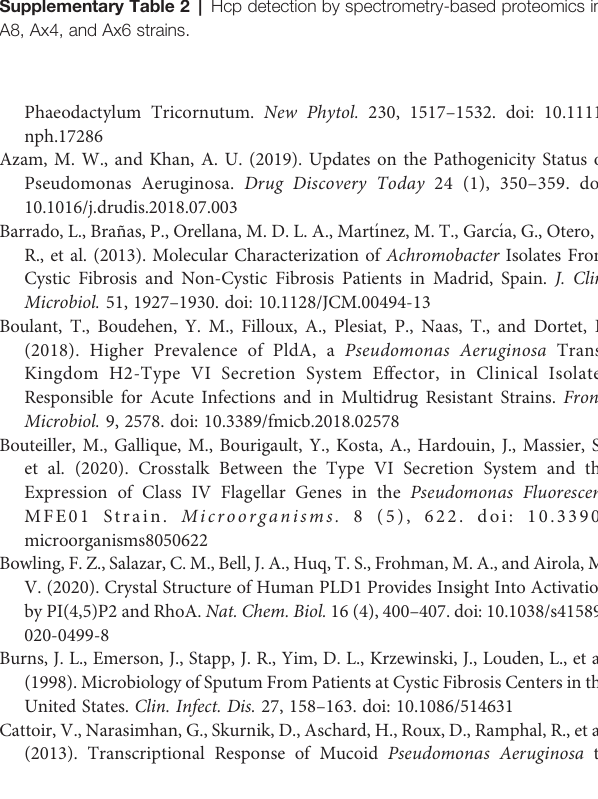
line) or VB (dashed line) medium. Lines and fi lled area represent the averages and standard deviation, respectively. Supplementary Figure 3 | Sequence alignment of AXYL_05707 with predicted homologsTle5andTle5bfrom P.aeruginosa .Themultiplesequencealignmentwas generated with the web server T-Coffee using PSI-Coffee mode. The conserved catalytic residues of HKD domains (box) are indicated above the alignment with black arrows. Supplementary Figure 4 | Growth of input strains as controls for. (A) Picture of a representative growth of strains used in competition assay on PIA or LB-Rif agar plates. 10-fold serial dilution drops are spotted after incubation on VB agar during 6 h at 28°C. This analysis shows no growth difference between A8 and A8 D tssL . (B) LDH released by A549 after 4, 8, and 48 h of infection at multiplicity of infection (MOI)1:1. (C) Percentage ofA549cellsmortality counted withtrypanblue after 4,8, and 48 h of infection at MOI 1:1. Supplementary Figure 5 | Volcano Plot of differentially secreted proteins of Ax4 grown in LB versus VB. TAX-1 proteins are shown in red, proteins from T3SS in green and those related to fl agella in blue. Supplementary Figure 6 | Deletion of tssL affects A8 competition against E. coli andPAO1.Pictureofreplicatesofcompetition assaysshowingsurvivalofMG1655- Rif (A) orPAO1-Rif (B) after co-incubationwith Achromobacter A8orA8 D tssL . Prey and attacker were mixed in a 1:10 ratio and incubated 6 h at 28°C on VB agar. Surviving preys are observed after spotting 10-fold serial dilutions of the mix on LB agar containing rifampicin. Supplementary Figure 7 | T6SS expression in clinical isolates. qRT-PCR analysis of tssM (A) and hcp (B) expression in clinical isolates from CF sputum (x5), blood infection (x2), and environmental (x2) origins. Data from three biological replicates are normalized with the housekeeping gene nrdA . Supplementary Table 1 | Primers used in the